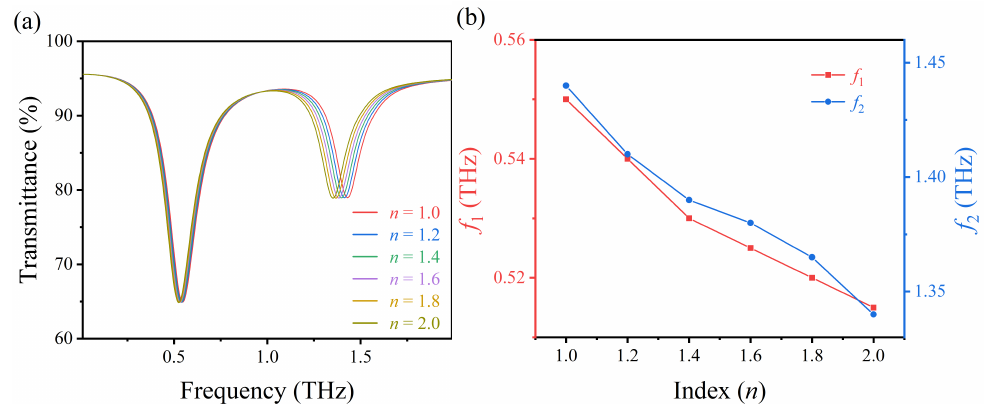
Figure 10. ( a , b ) Refractive index sensing characteristics of the AIGS.